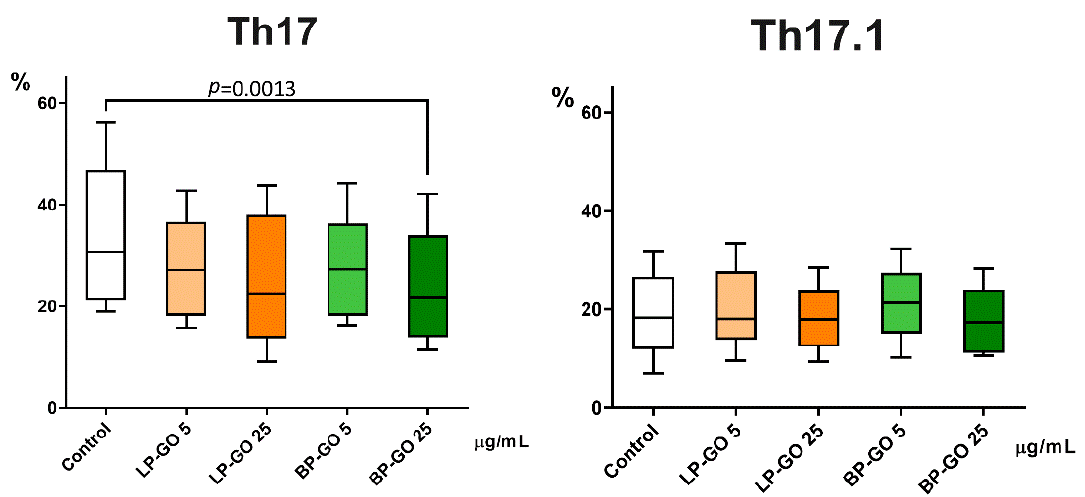
Figure 7. Percentage of “classical” Th17 (CCR4+CXCR3 -) and Th17.1 (CCR4 - CXCR3 + ) from CD4 + CCR6 + cells in T helper cultures supplemented with PEGylated GO particles in two concentra- tions. Note: the x -axis indicates the type and concentration of nanoparticles; the y -axis is the per- centage of cells. Control — culture without GO. Data are presented as median (Me) and quartiles (Q1 – Q3).